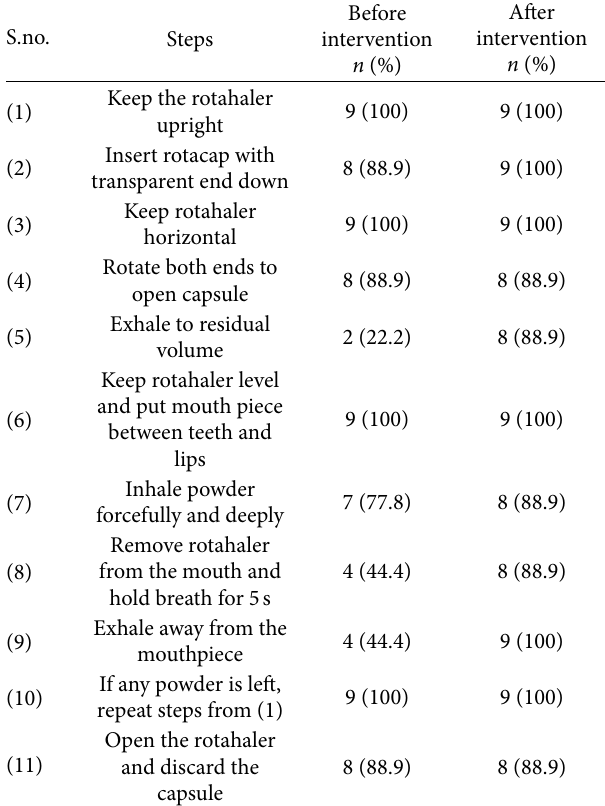
n indicates number of patients and values in the bracket indicate percentage.